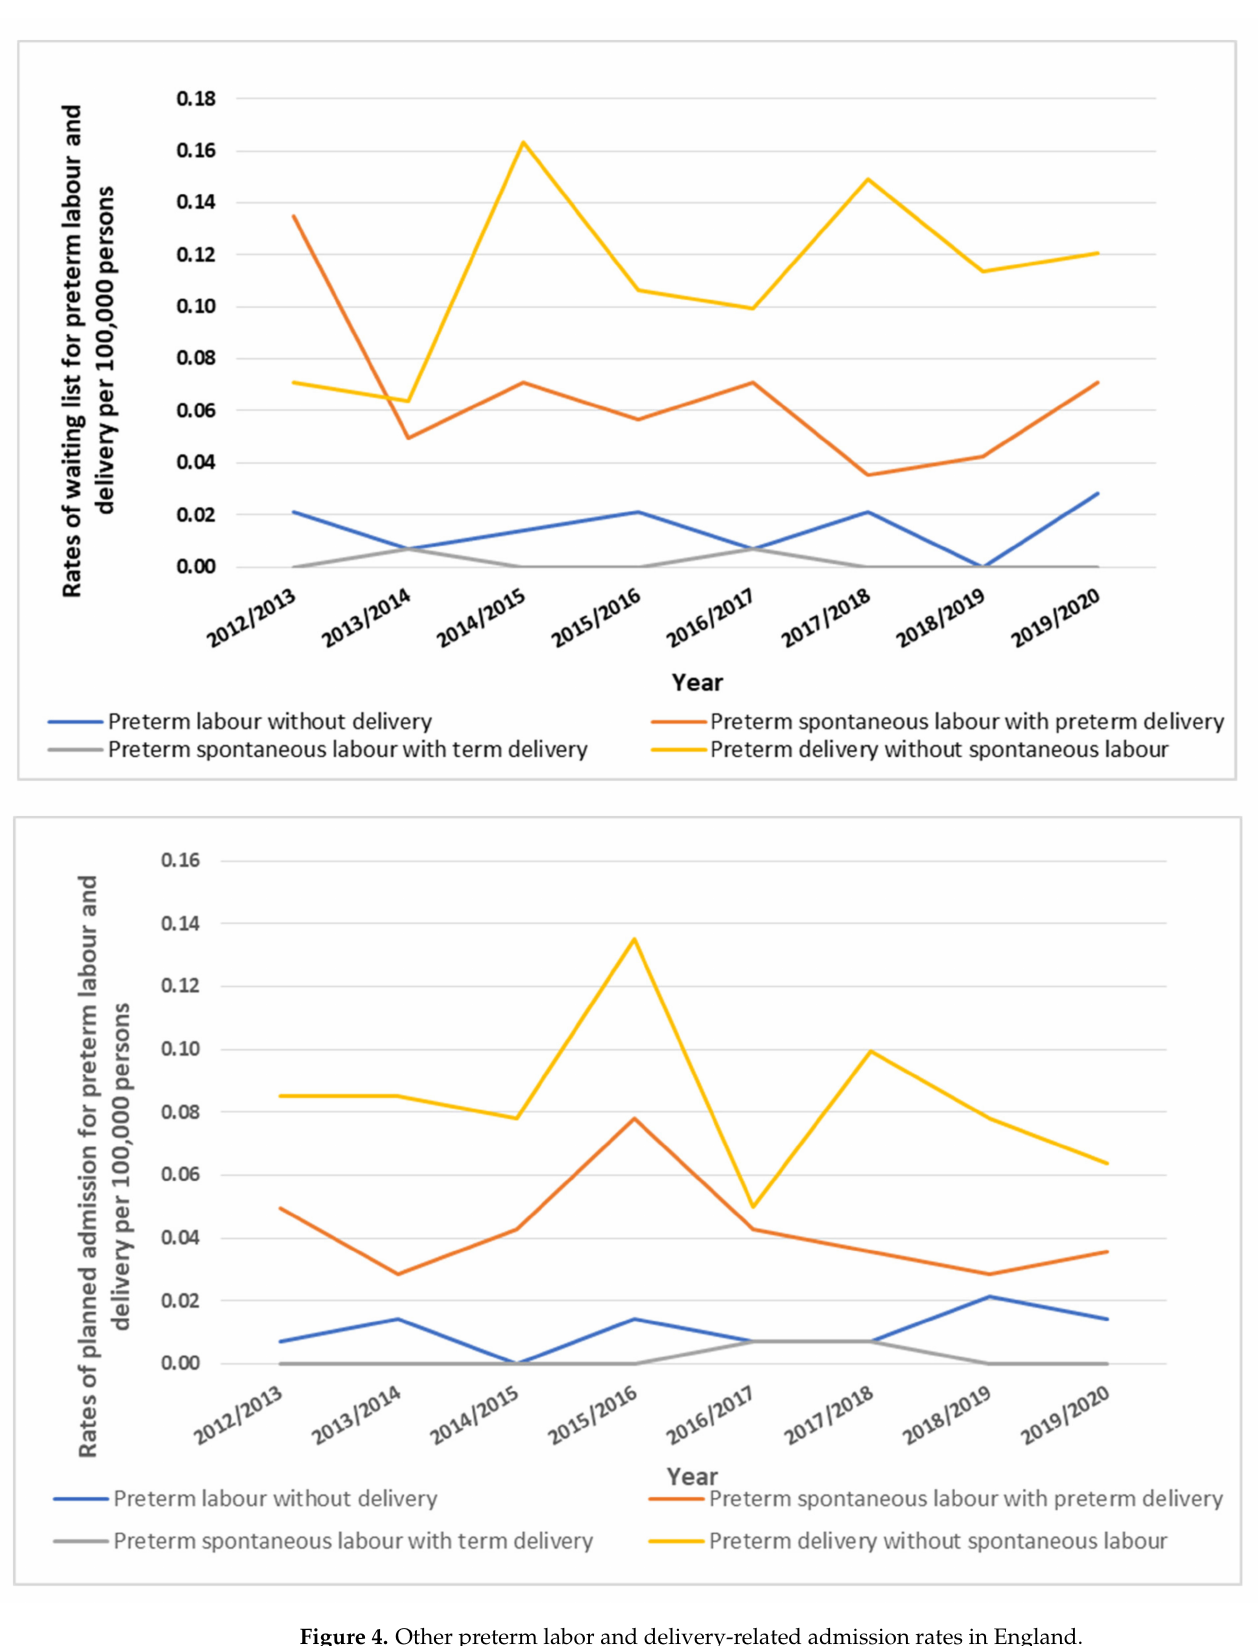
Figure 4. Other preterm labor and delivery-related admission rates in